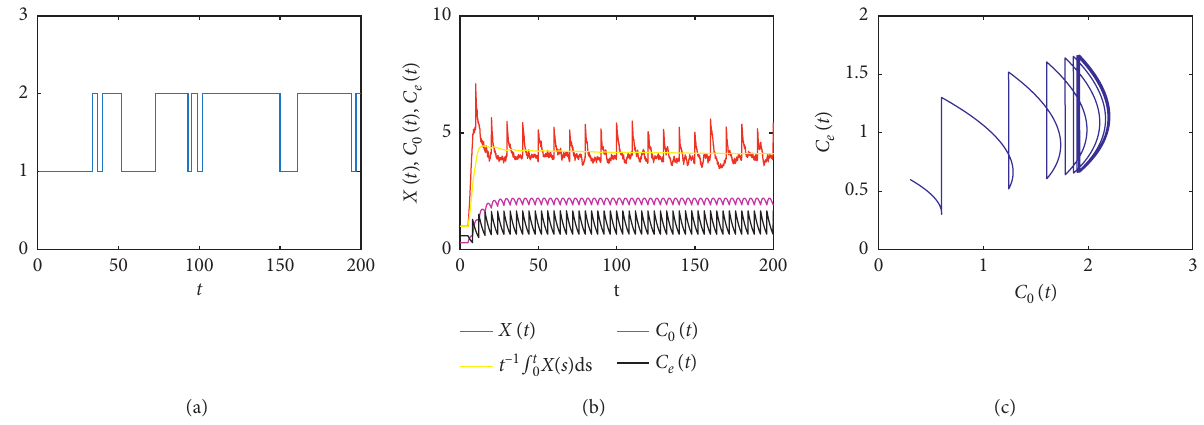
Figure 1: (a) Markov chains, (b) the time sequence diagram, and (c) the phase portrait of C